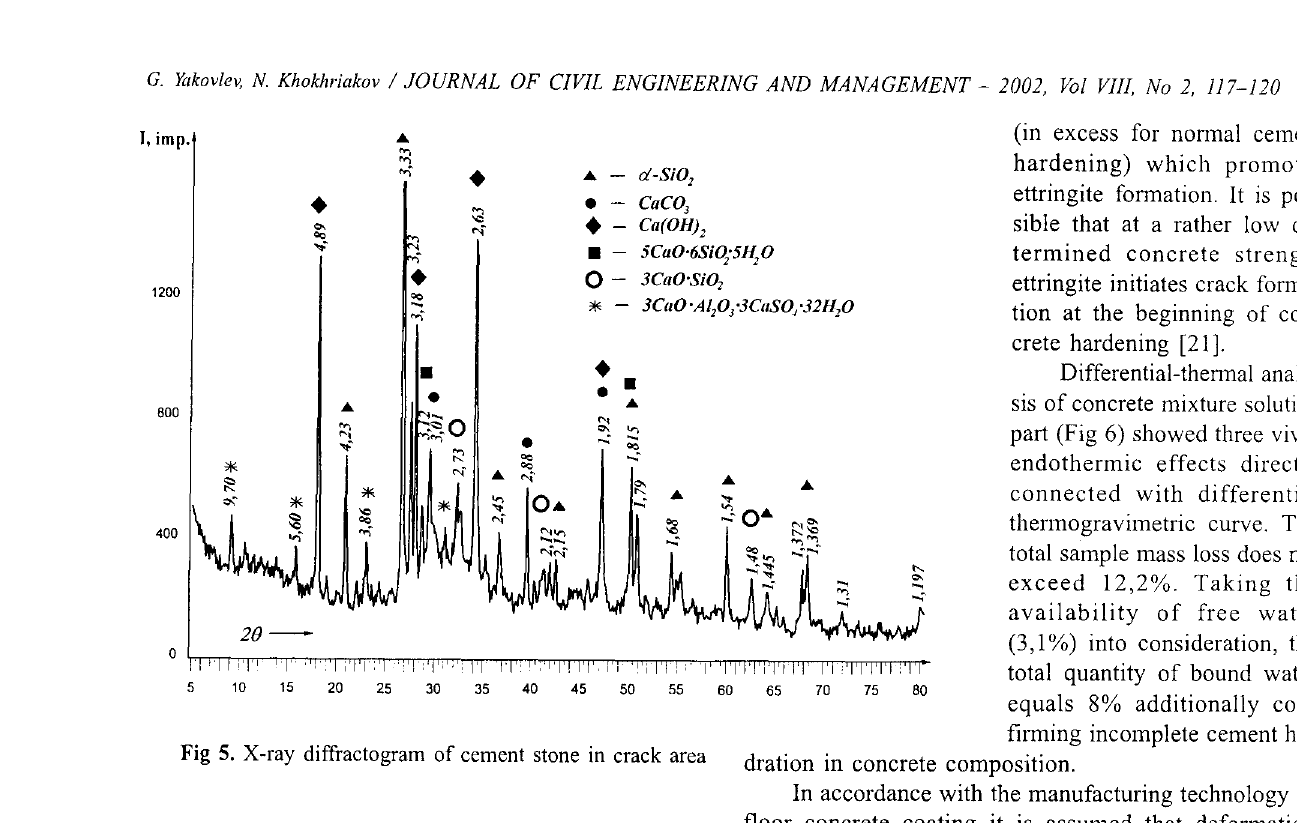
indicates that cracks are fanned due to the concrete sur face bending as a result of uneven shrinkage in harden ing concrete.